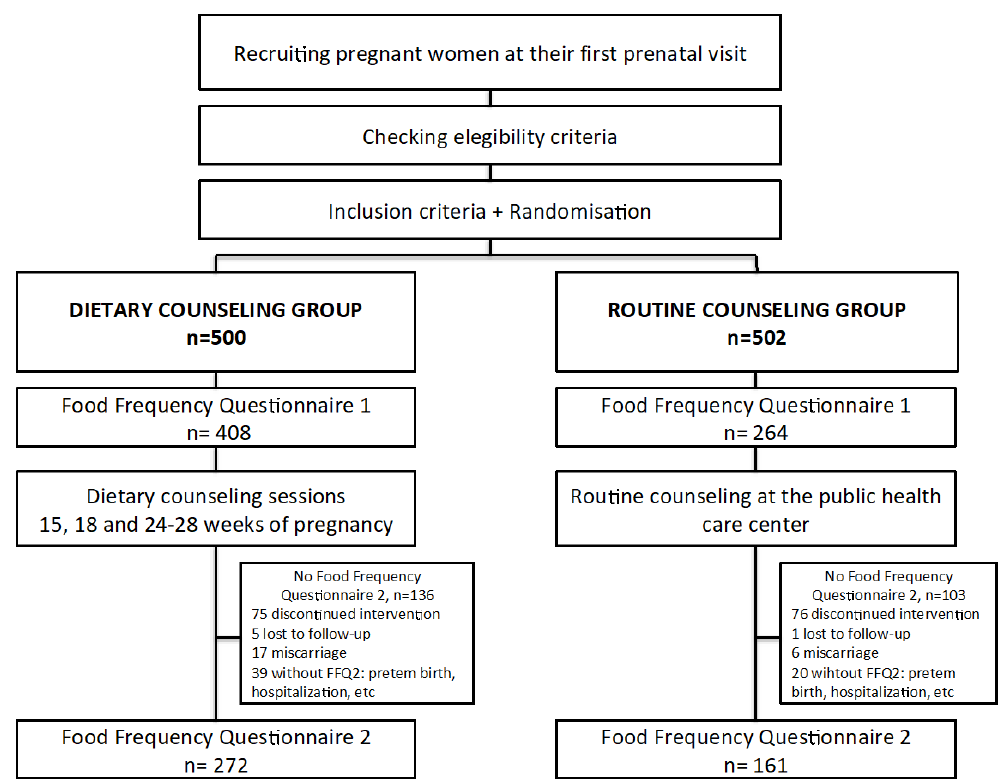
Figure 1. Flow diagram of the recruitment, randomization, and dietary measurements of trial participants.